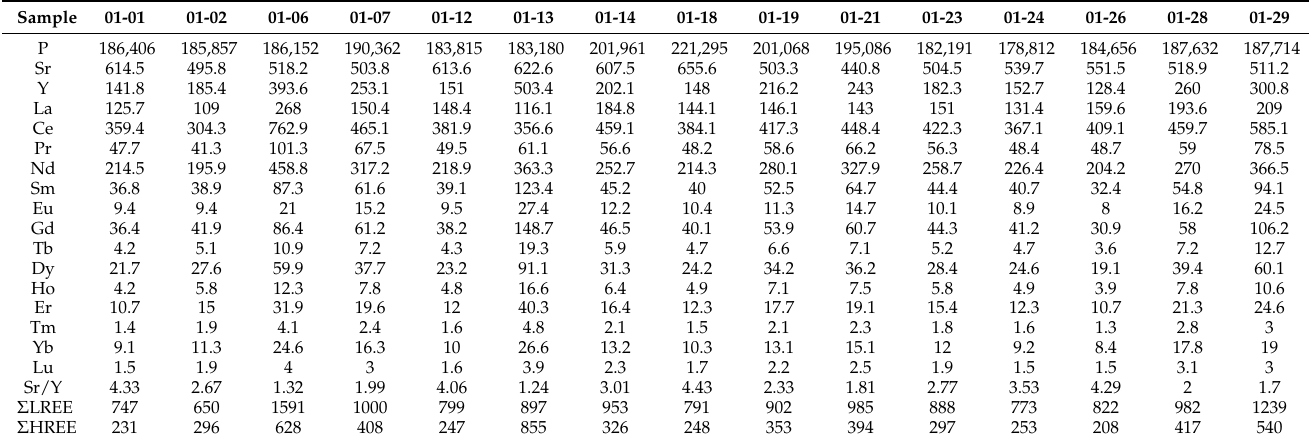
Table 2. LA-ICP-MS apatite trace element